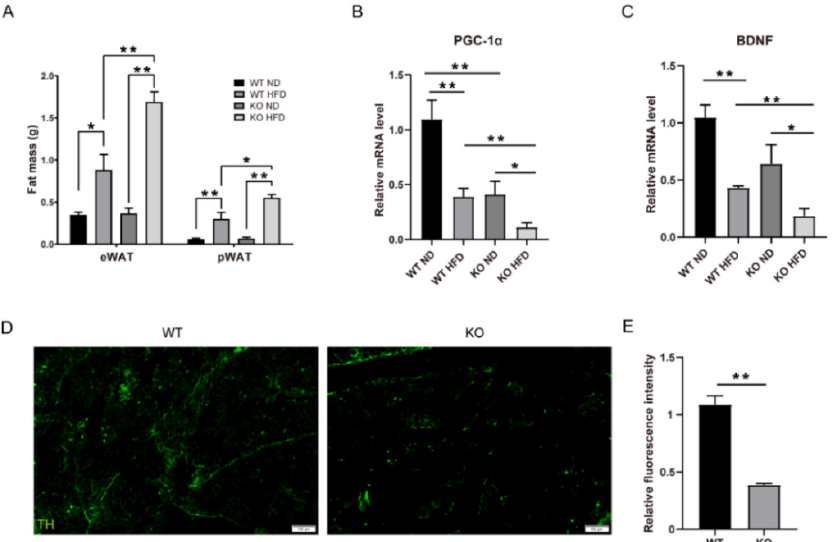
Figure 4. TRIM67 deletion reduces the fat sympathetic nervous system innervation via BDNF. ( A ) The weight of fat from each group ( n = 8). ( B ) The expression levels of PGC-1 α in WAT from each group ( n = 4). ( C ) The expression levels of brain-derived neurotrophic factor (BDNF) in hypothalamus ( n = 4). ( D ) The immunostaining of TH in BAT and imaging by Olympus software ( n = 3). ( E ) Quantification of fluorescence density of TH ( n = 3). Four samples from each group were used for RT-qPCR analysis and two duplicate samples were measured. The data are presented as means ± SEM. * p -value < 0.05; ** p -value < 0.01.